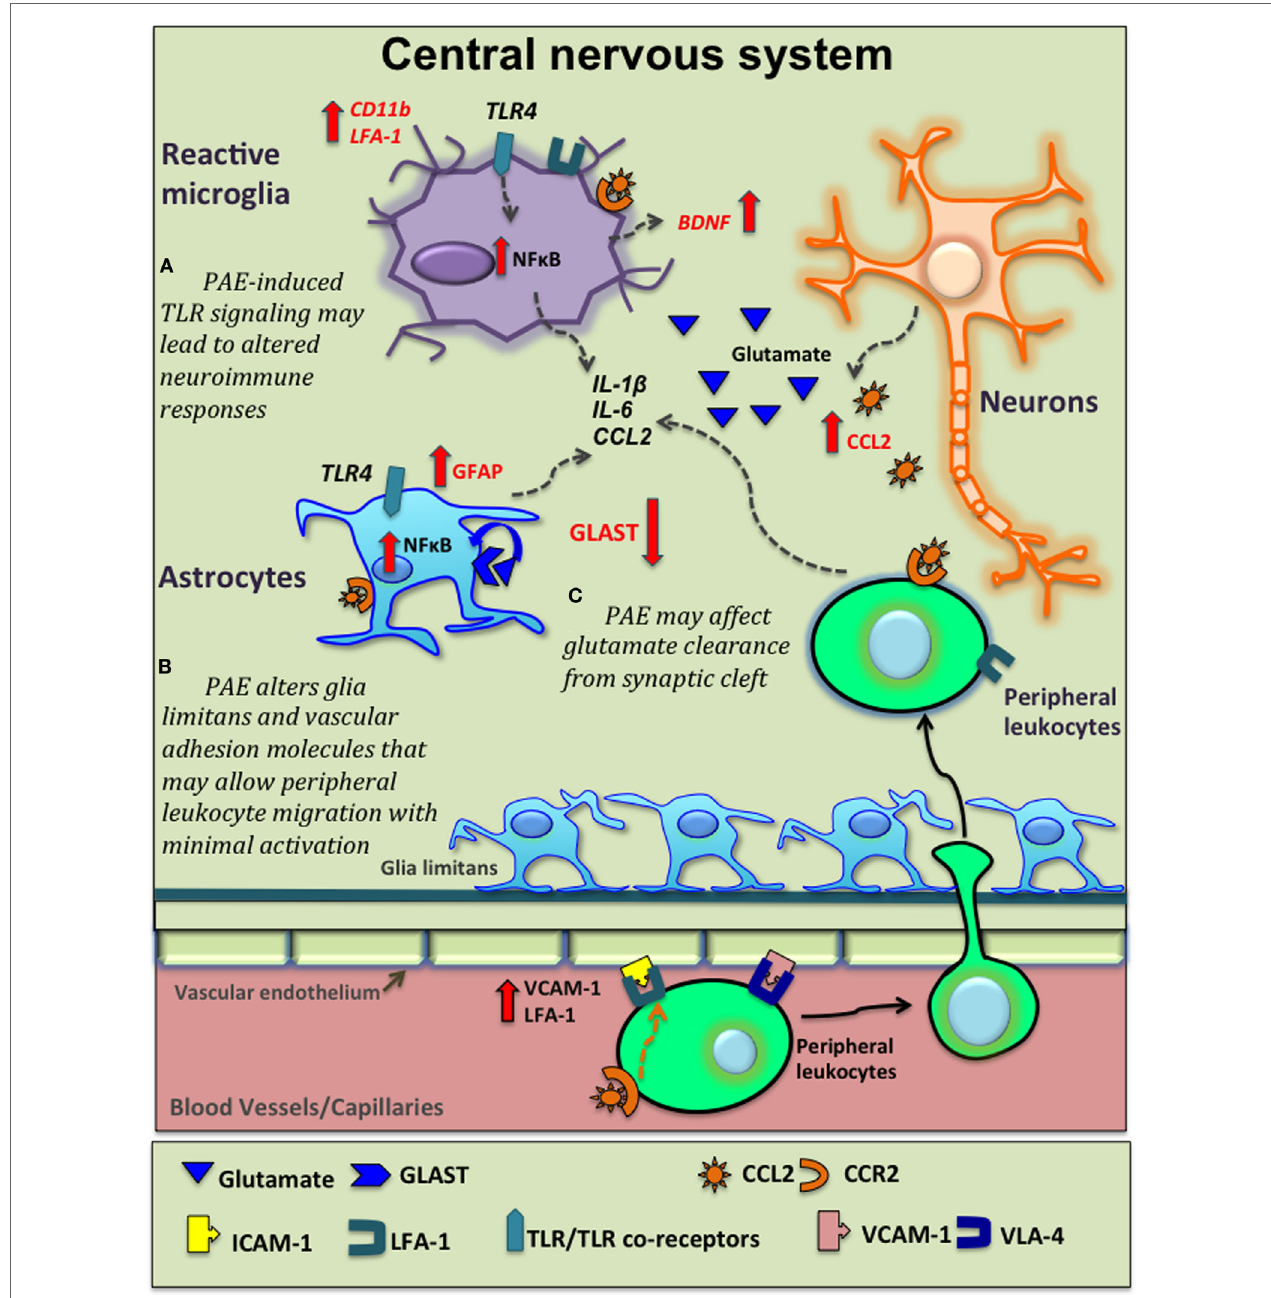
FiGURe 2 | Potential venues of prenatal alcohol exposure (PAE) altering neuroinflammation. Moderate PAE leads to epigenetic alterations of neural gene expression that may extend to glial-immune cells altering their basal activation status and function (not shown here). Based on current supporting evidence, this schematic diagram shows several other potential mechanisms underlying PAE’s contribution to central nervous system (CNS) inflammation. (A) PAE-induced toll-like receptor 4 (TLR4)-mediated signaling activates the NF κ B pathway in microglia and astrocytes leading to production of various inflammatory cytokine, as explored in high- alcohol exposure models. PAE-induced expression and function of TLRs may lead to altered neuroimmune responses followed by subsequent immune activation. (B) PAE increases C–C motif chemokine ligand-2 (CCL2) production in the CNS that may be released damaged neurons in the CNS and also via blood-brain-barrier (BBB). CCL2 acts on peripheral leukocytes to recruit them to the CNS. Glial cells also express C–C motif chemokine receptor 2 (CCR2) and produce inflammatory cytokines in response to CCL2. Similarly, PAE-induced increases in adhesions molecules such as vascular cell adhesion molecule-1 [VCAM-1, binds with very late antigen-4 (VLA-4) on leukocytes] and leukocyte function-associated antigen-1 (LFA-1), in conjunction with altered morphology of glia limitans, may facilitate and increase the magnitude of peripheral leukocyte migration across BBB following subsequent immune activation. (C) PAE decreases glutamate aspartate transporter (GLAST) expression and/or function, decreasing normal glutamate removal by astrocytes, with consequent increased neuronal activation, augmenting pathological neuroimmune